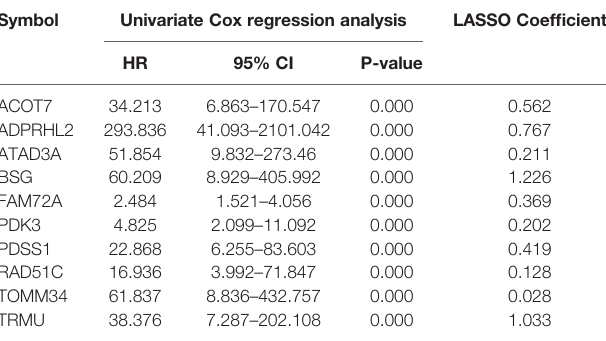
TABLE 1 | The mitochondrial-related genes in the prognostic classi fi er associated with HCC in the TCGA data set. Symbol Univariate Cox regression